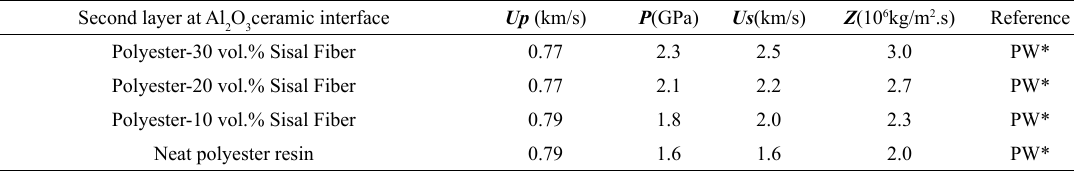
Table 2. Calculated parameters for the impedance matching analysis (Eq.2).